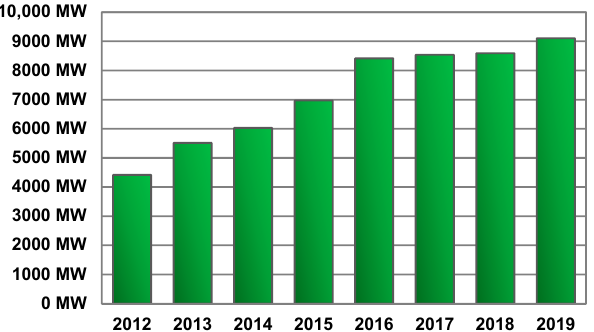
Figure 6. Renewable energy power (MW) in Poland. Source: Energy Regulatory Office (as of 31.12.2019).